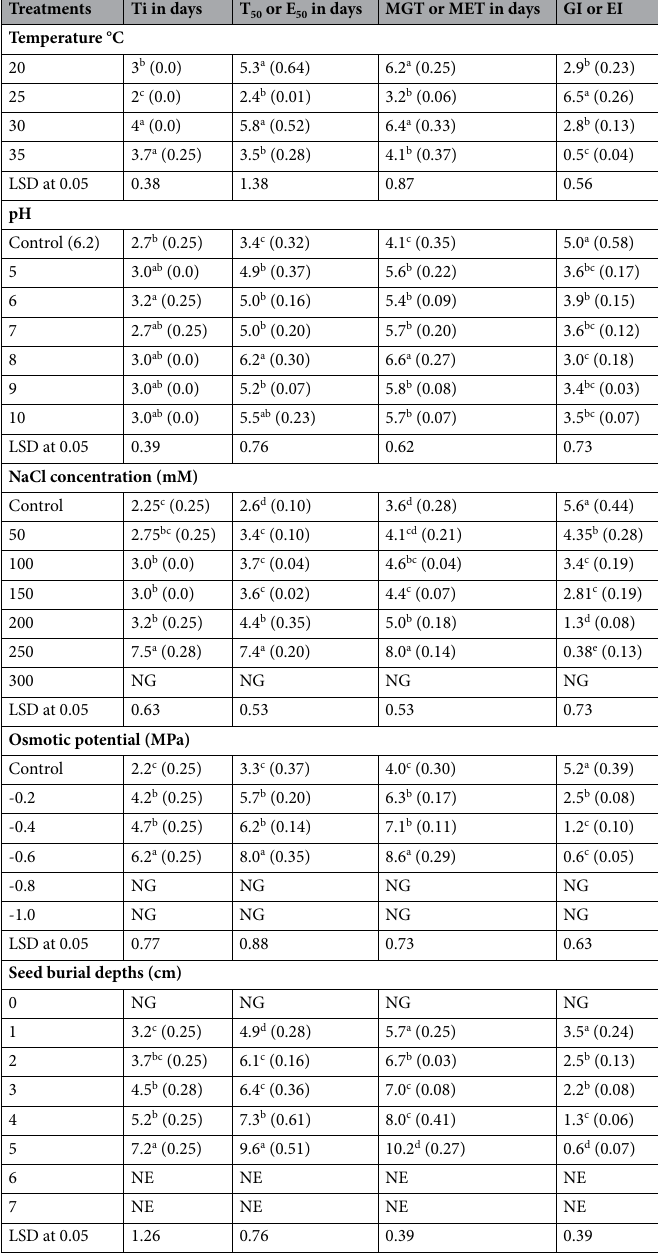
Table 1. Effect of temperature, pH, NaCl concentration, osmotic potential and seed burial depths on germination parameters of perennial ryegrass. Ti, time to initial germination; T 50 or E 50, time to obtain 50% germination or emergence; MGT or MET, mean germination or emergence time; GI, germination index; EI, emergence index; NG or NE, no germination or emergence. The values within the column followed by different letters were significantly different at P ≤ 0.05. LSD = Least significant difference. Values in parentheses are standard errors of the